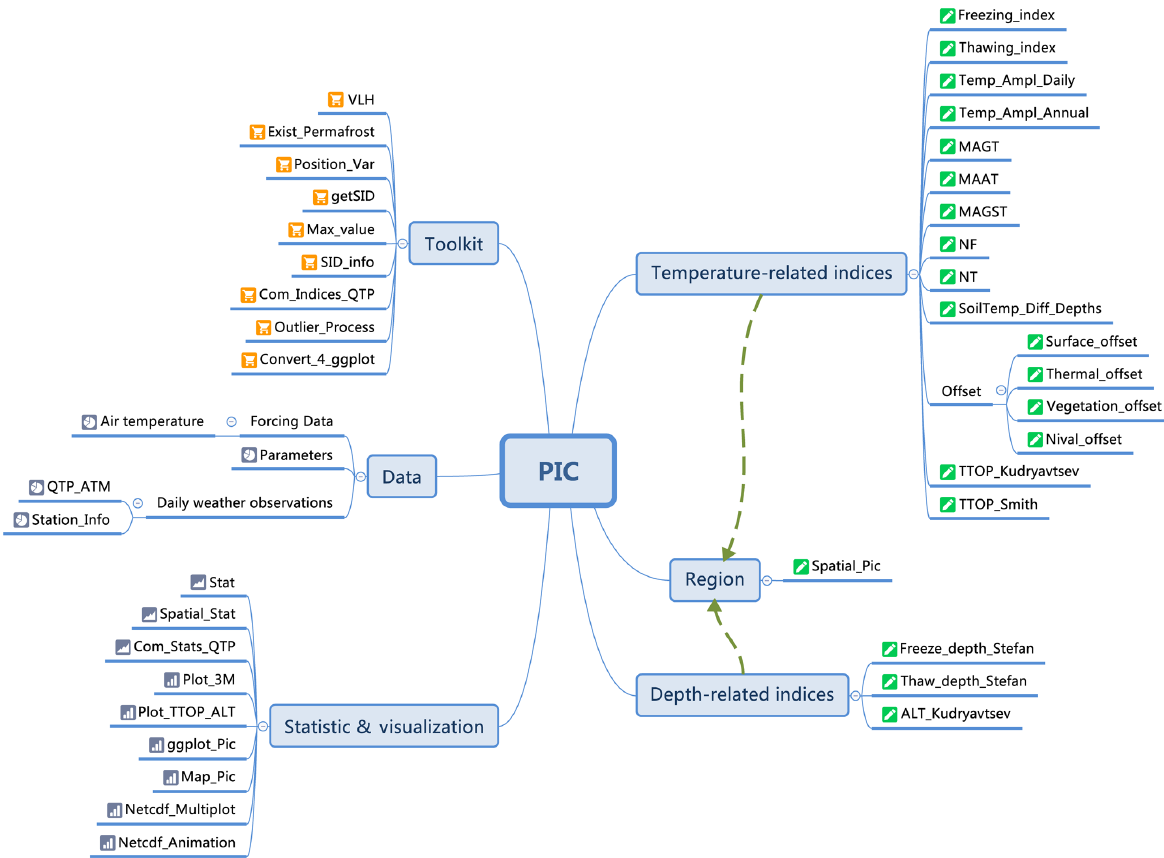
Figure 2. Mind map of the R package PIC